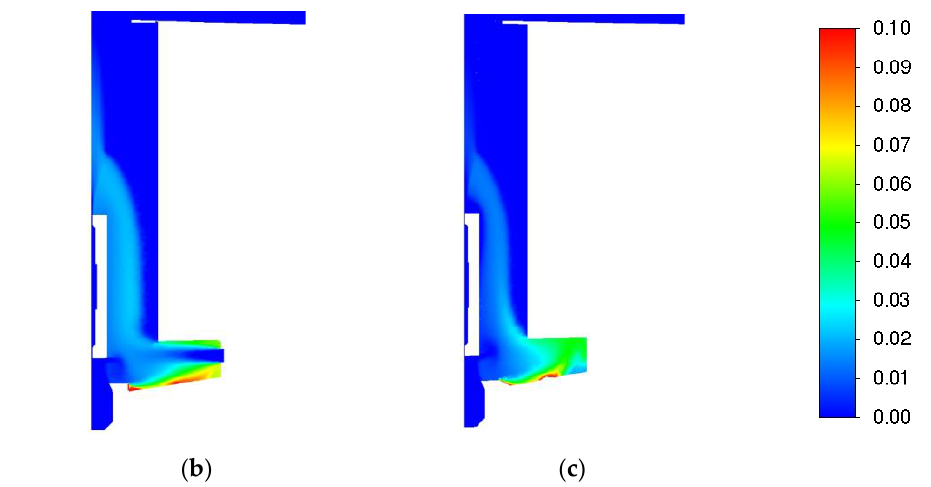
Figure 19. Volume fraction of C 7 H 16 : ( a ) 1 reaction EDC; ( b ) 60 reactions EDC; ( c ) 305 reactions EDC.